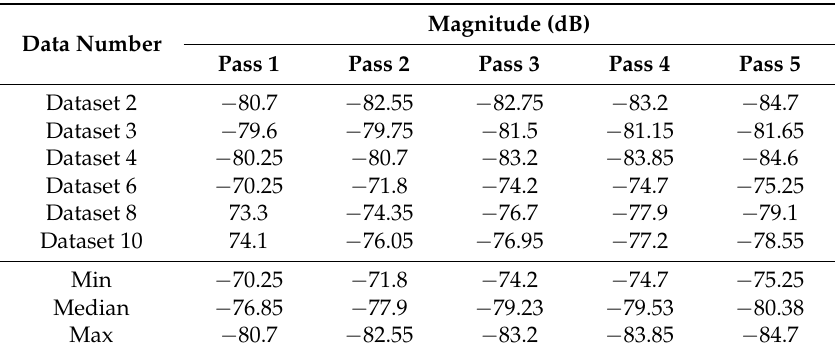
Table 4. Training data for FIS